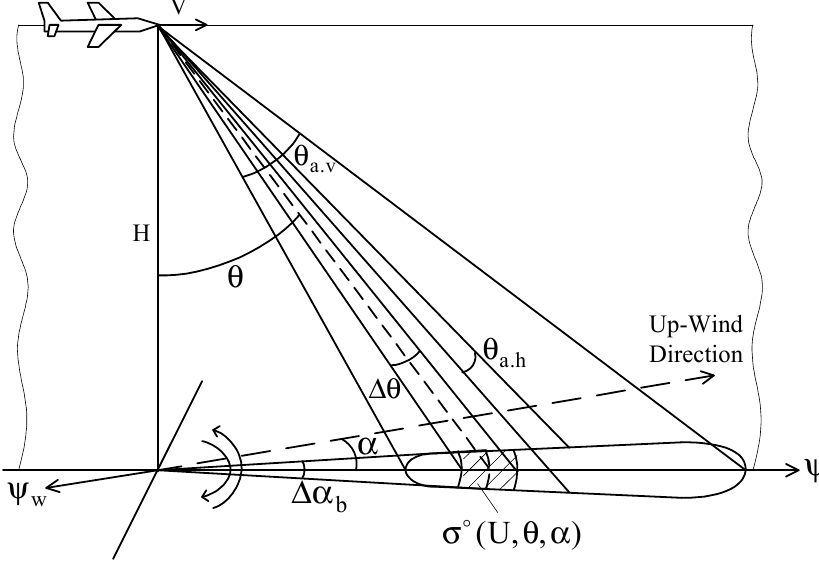
Figure 1. Airborne weather radar (AWR) ground looking beam and selected cell geometry. V is the speed of flight; H is the aircraft altitude; θ is the incidence angle of the selected cell; ψ is the aircraft course; θ a.v is the beamwidth in the vertical plane; θ a.h is the beamwidth in the horizontal plane; Δα b is the angular resolution in the azimuthal plane; Δ θ is the angular resolution in the vertical plane; ( , , ) U σ θ α is the current normalized radar cross section (NRCS) value.